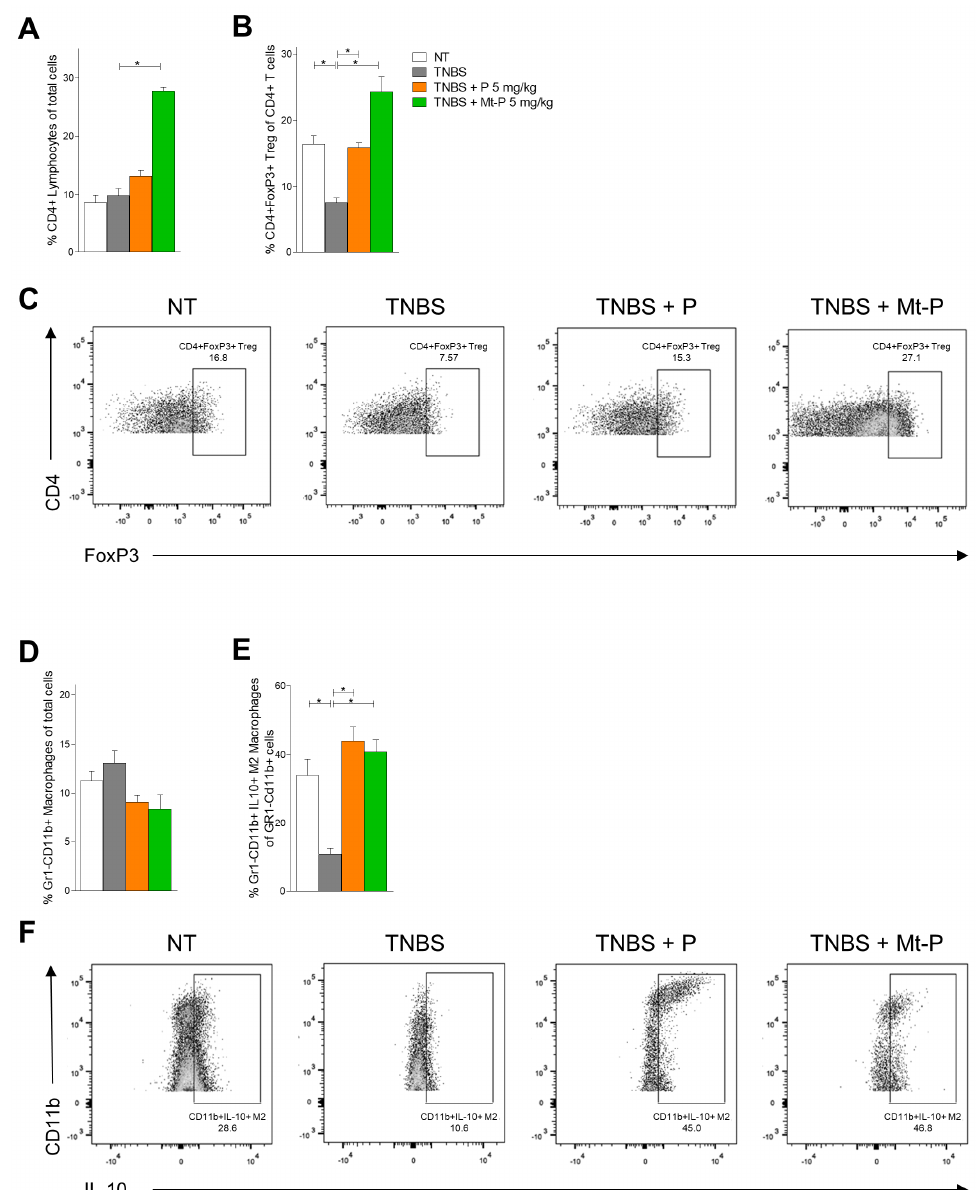
Figure 5. E ff ect of P and Mt-P on the polarization of the LP immune cells in the TNBS model of colitis. Frequency of immune cells in the colonic lamina propria (LP): ( A ) CD4 + cells and ( B ) CD4 + FoxP3 + cells. ( C ) Flow cytometry analysis of FoxP3 expression in CD4 + cell recruited into the LP. Frequency of ( D ) CD11b + Gr1-macrophages and ( E ) CD11b + Gr1-IL-10 + M2 macrophages in the colonic LP. ( F ) Flow cytometry analysis of Il-10 expression in CD11b + Gr1-macrophages recruited into the LP. Results are the mean ± SEM of five / eight mice per group (NT = 5; TNBS = 8; TNBS + P 5 mg / kg = 6; TNBS + Mt-P 5 mg / kg = 8). (* p < 0.05).